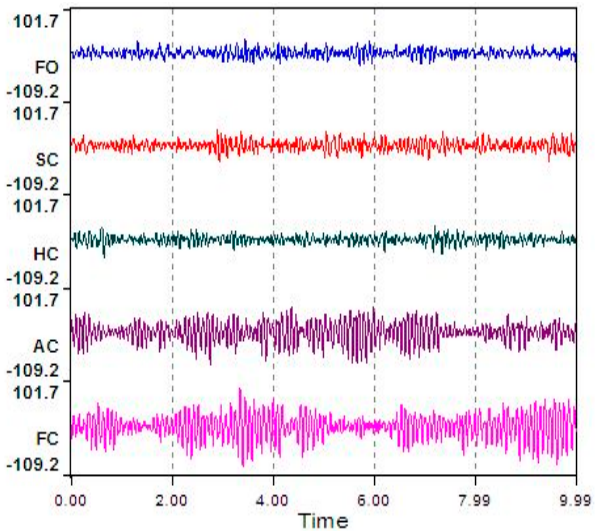
Figure 4. The typical signals for one trial EEG